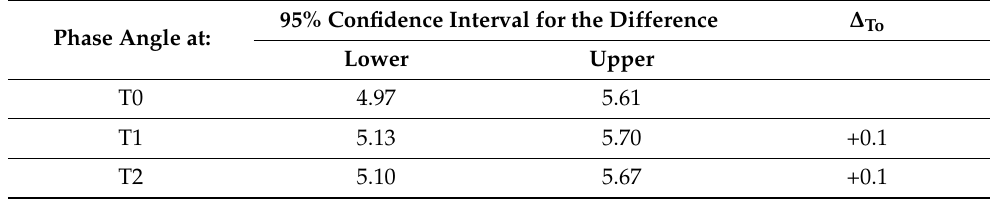
Table 7. Acupuncture—lower and upper values of the phase angle (Xc/Rz × 180/ π ). The deltas of the average phase angle values ( ◦ ) are